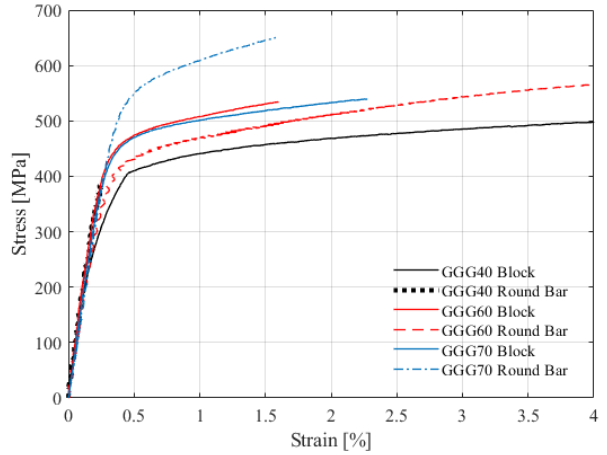
Figure 6. Tensile test